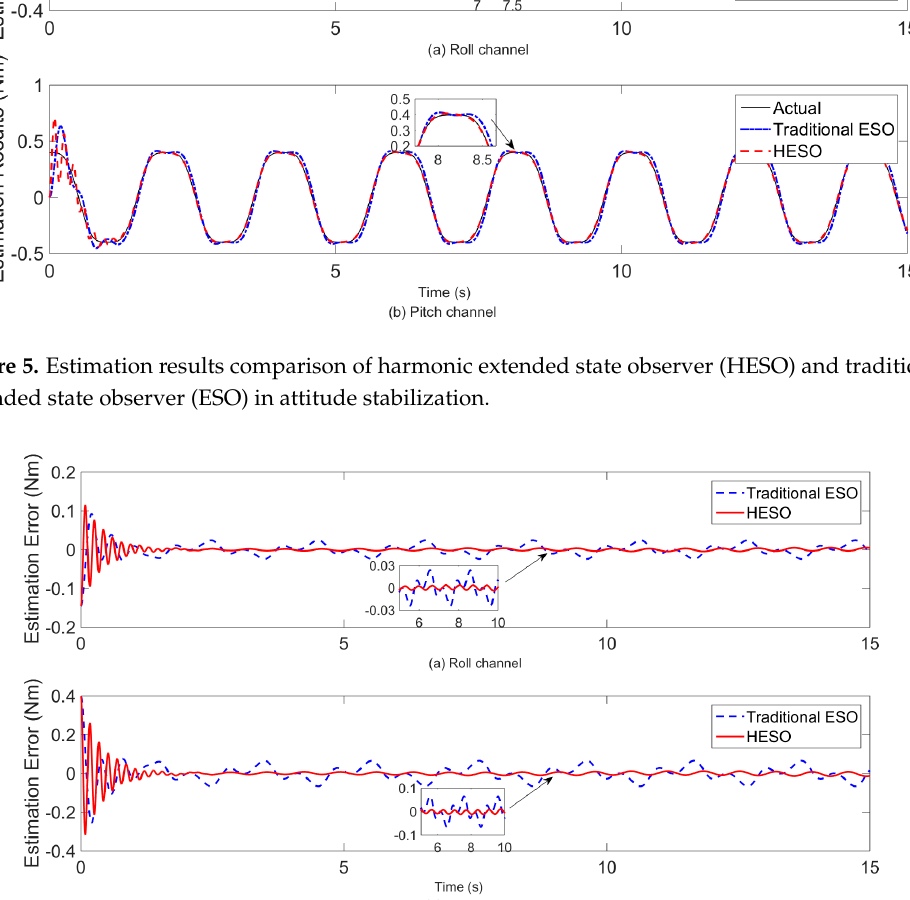
Figure 6. Estimation errors comparison of HESO and traditional ESO in attitude stabilization.